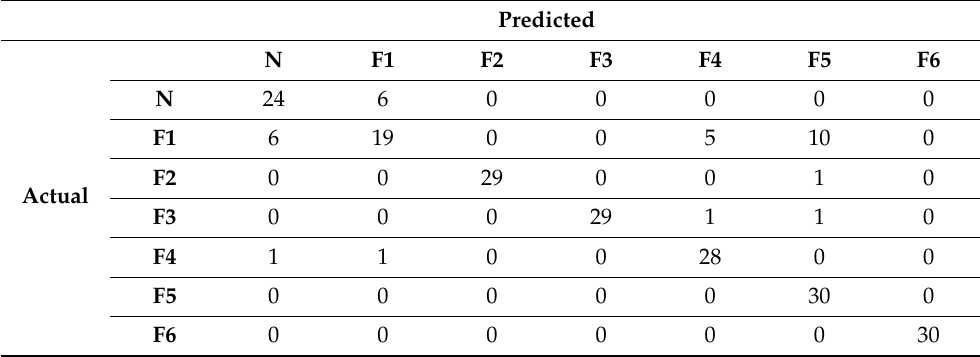
Table 5. Pick And Place: confusion matrix with PA dataset, over unseen data.